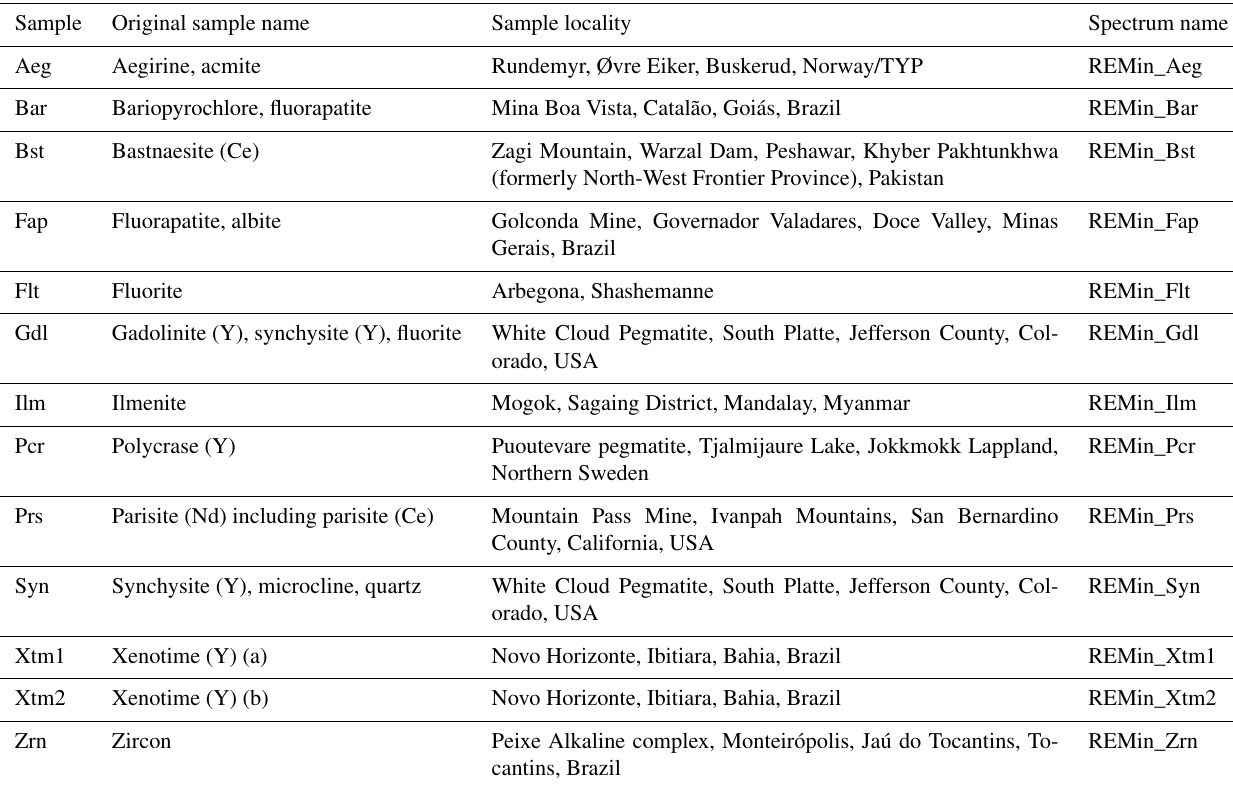
Table 8. Samples, sample names and locality, and spectral library filenames of REE-bearing minerals. Sample